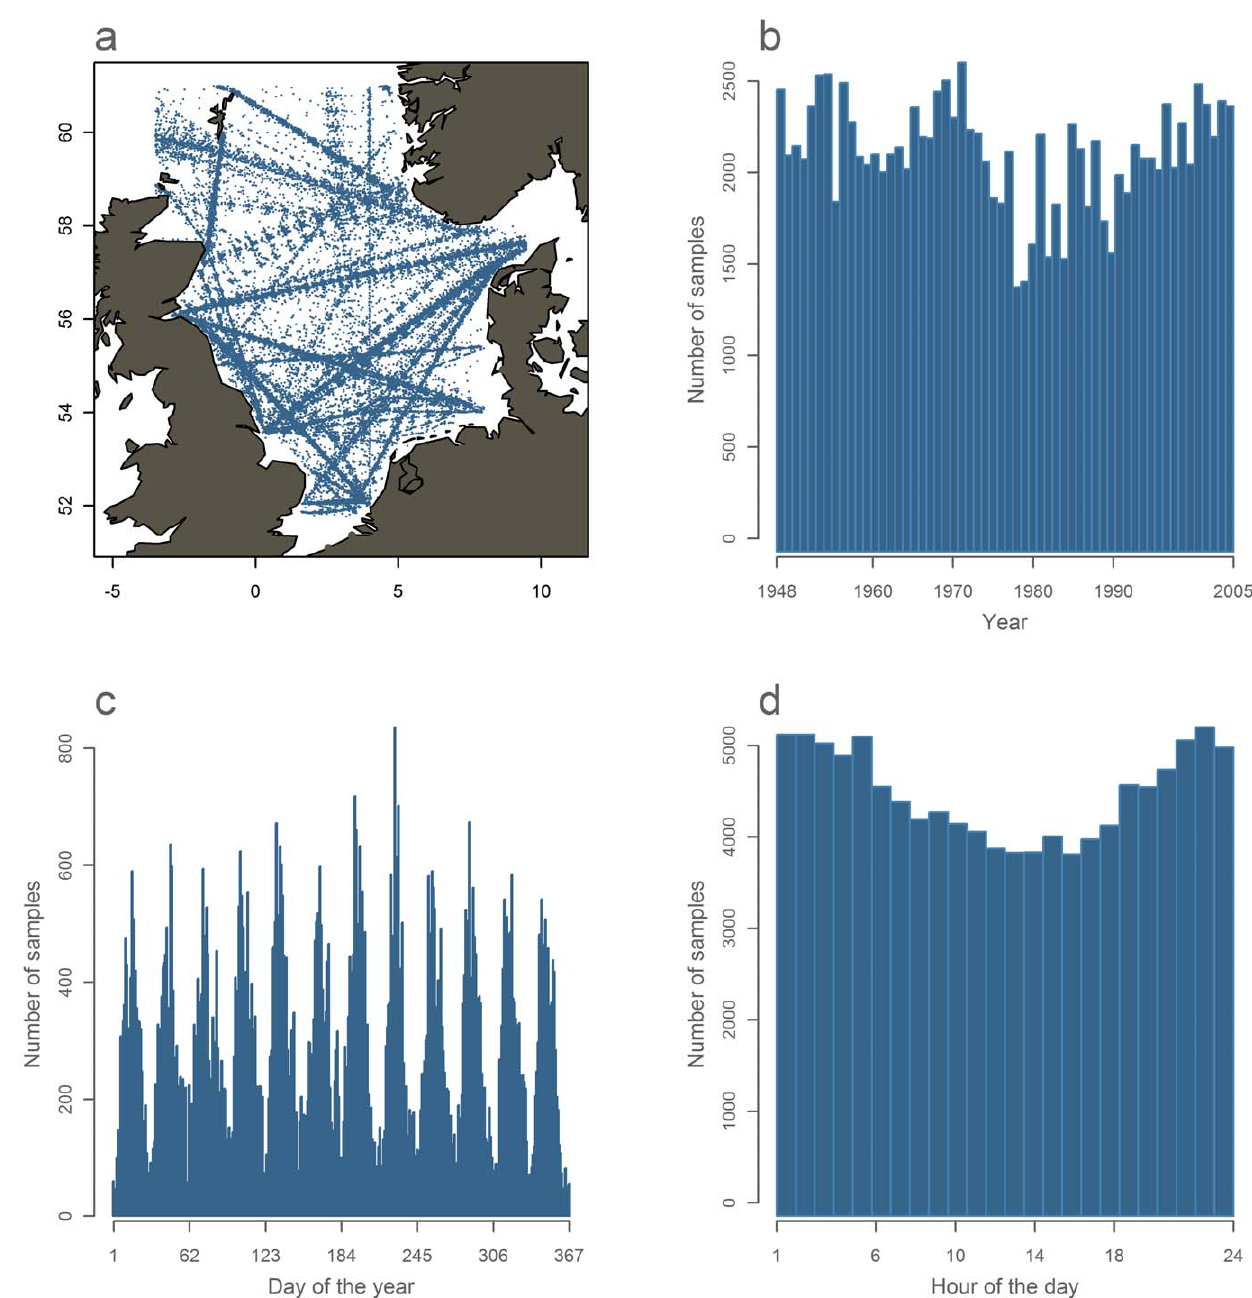
Figure 2. Continuous plankton recorder samples from 1948–2005 in the studied area. a) map of samples locations. b) number of samples by year. c) number of samples by day number of the year. d) number of samples by the hour of the